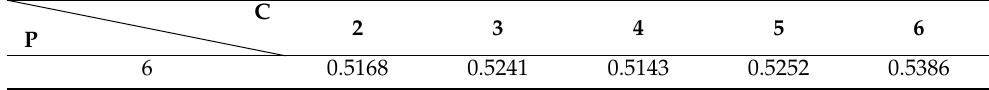
Table 6. Prediction performance of the optimized CGK-based fuzzy granular model with the aggre- gated